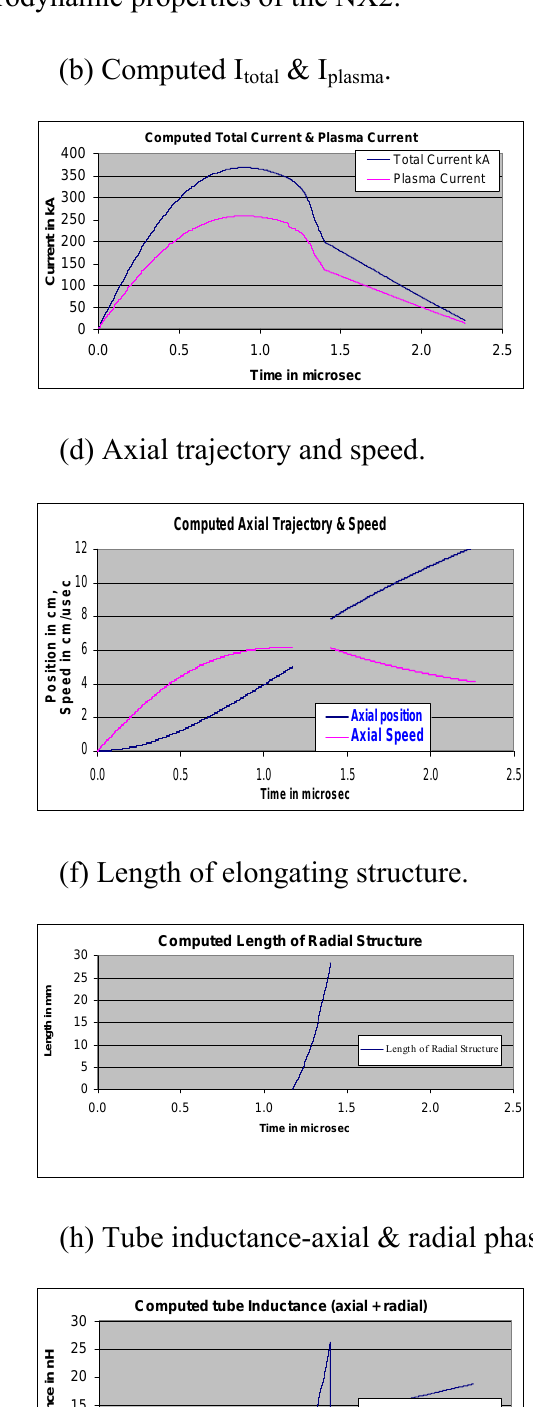
Figure 4. Computed plasma and electrodynamic properties of the